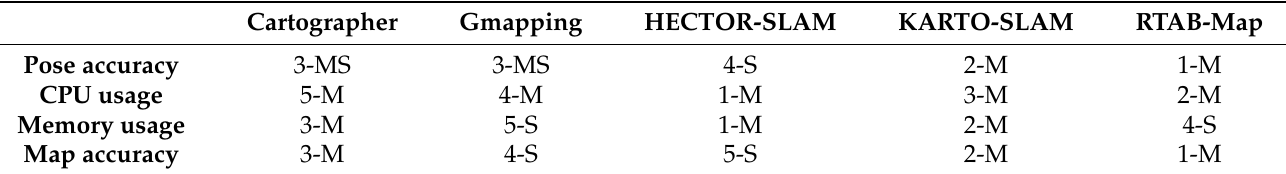
Table 15. Final results for all the metrics